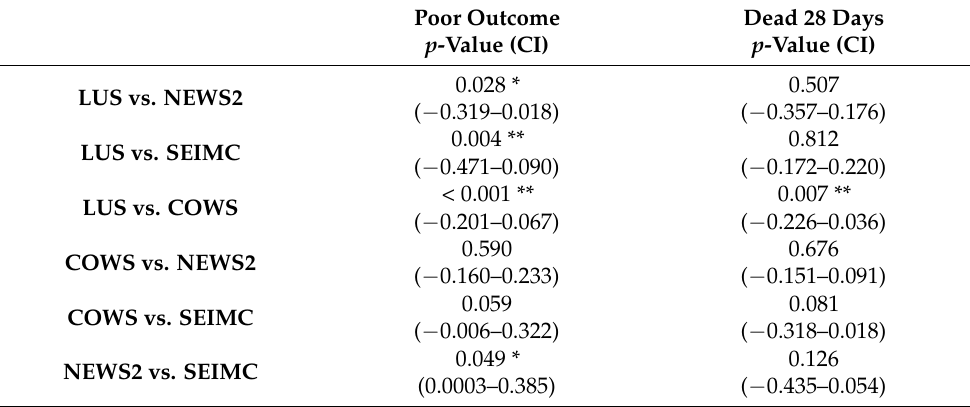
Table A2. Statistical differences between the AUC of the scores according to DeLong’s non-parametric method